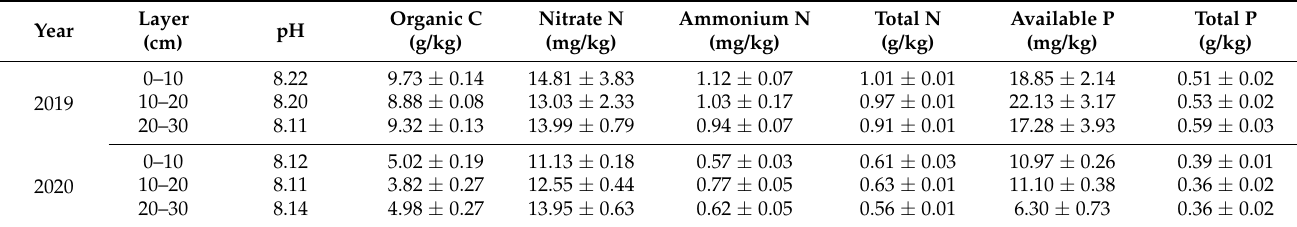
Table 1. Basic soil feature at the experimental